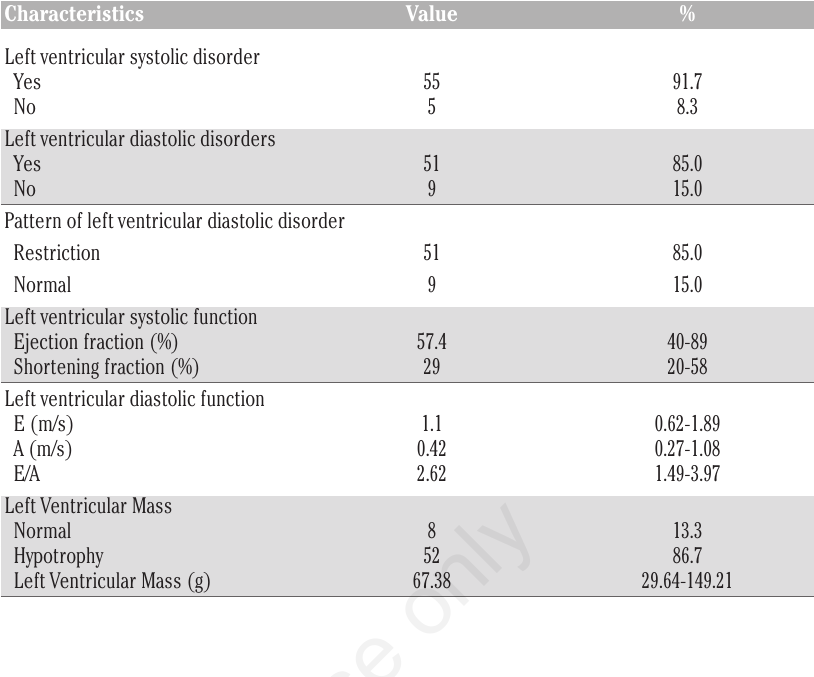
Table 2. Characteristics of subjects based on echocardiography